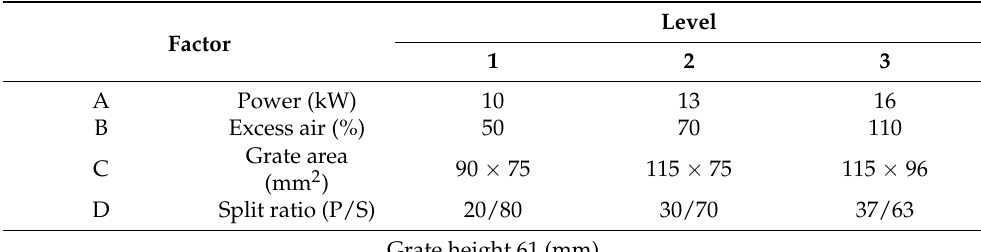
Table 2. Factor and Level of the experimental plan, using the Taguchi